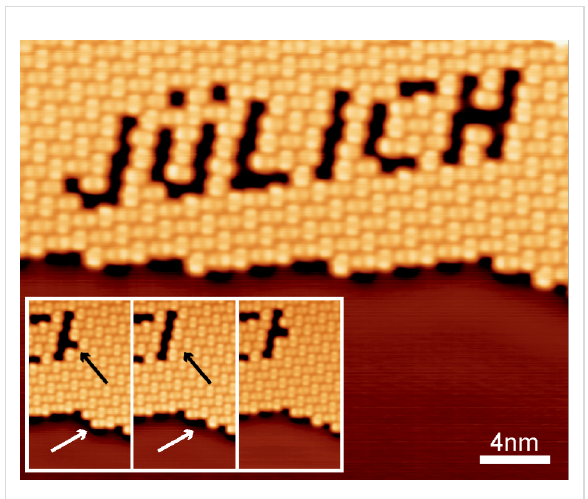
Figure 4: Constant current STM image of a structure consisting of 47 vacancies that were created by removing individual PTCDA mole- cules from the PTCDA/Ag(111) monolayer. The sequence of inter- mediate steps recorded during writing can be downloaded from the supplement. The three insets show the “repair” of a vacancy created by mistake. The black arrow marks the position of the error vacancy. The white arrow marks the position of the molecule at the edge of the molecular monolayer island that was used to fill the error vacancy. The molecule from the edge was removed by using the same manipulation protocol as for all other vacancies and was then placed into the error vacancy by approaching the tip to the vacancy and increasing the voltage steadily to 0.6